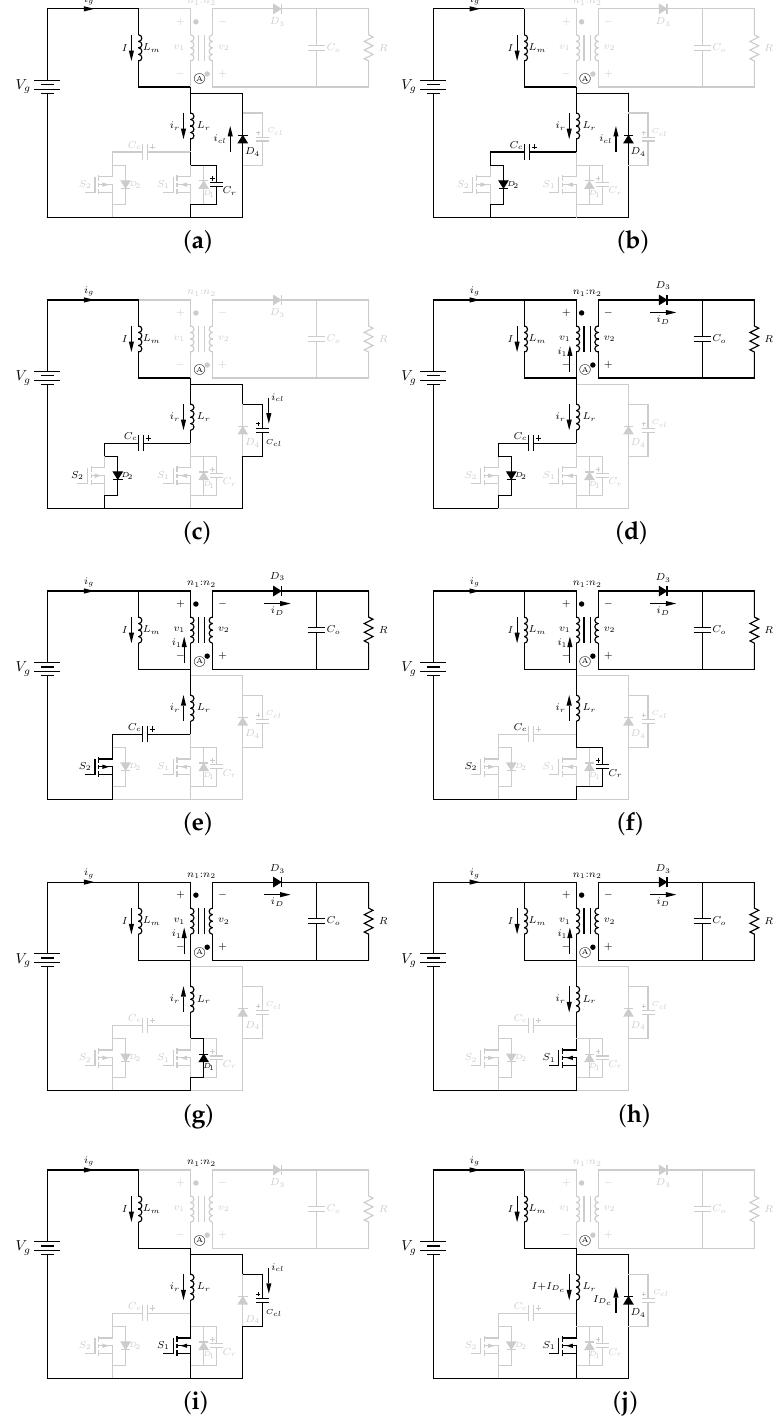
Figure 6. Equivalent circuits of the EACF during a switching period: ( a ) time interval 1; ( b ) time interval 2; ( c ) time interval 3; ( d ) time interval 4; ( e ) time interval 5; ( f ) time interval 6; ( g ) time interval 7; ( h ) time interval 8; ( i ) time interval 9; ( j ) time interval 10. The capacitance C cl represents all of the parasitic